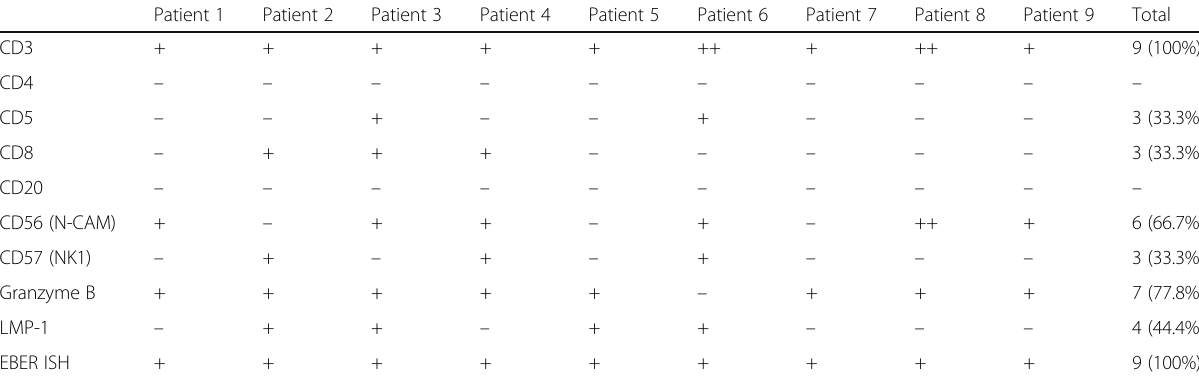
Table 3 Immunohistochemical and EBER in situ hybridization results